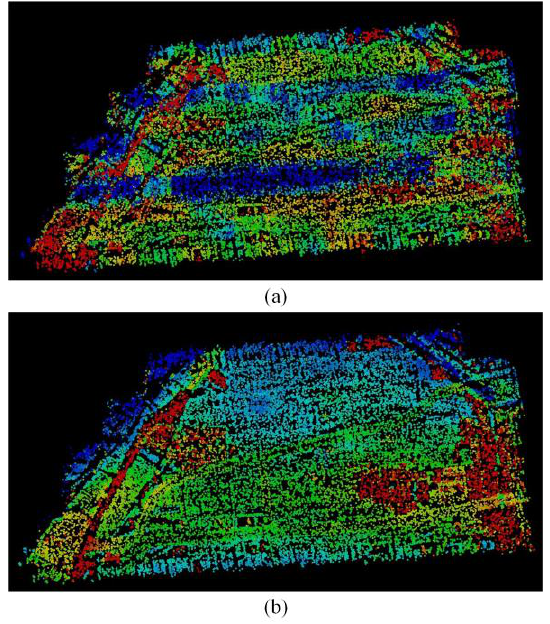
Figure 4. Point clouds. (a) and (b) show the point clouds before and after the self-calibration bundle adjustment with GPS information of Case I, respectively.